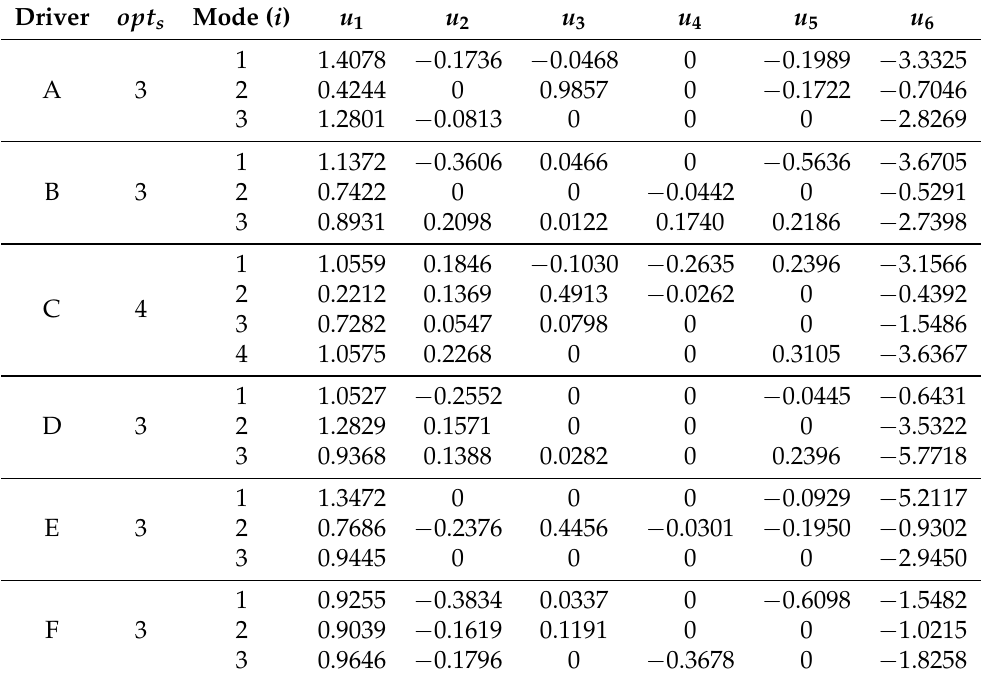
Table 4. Variable selection results with the identified